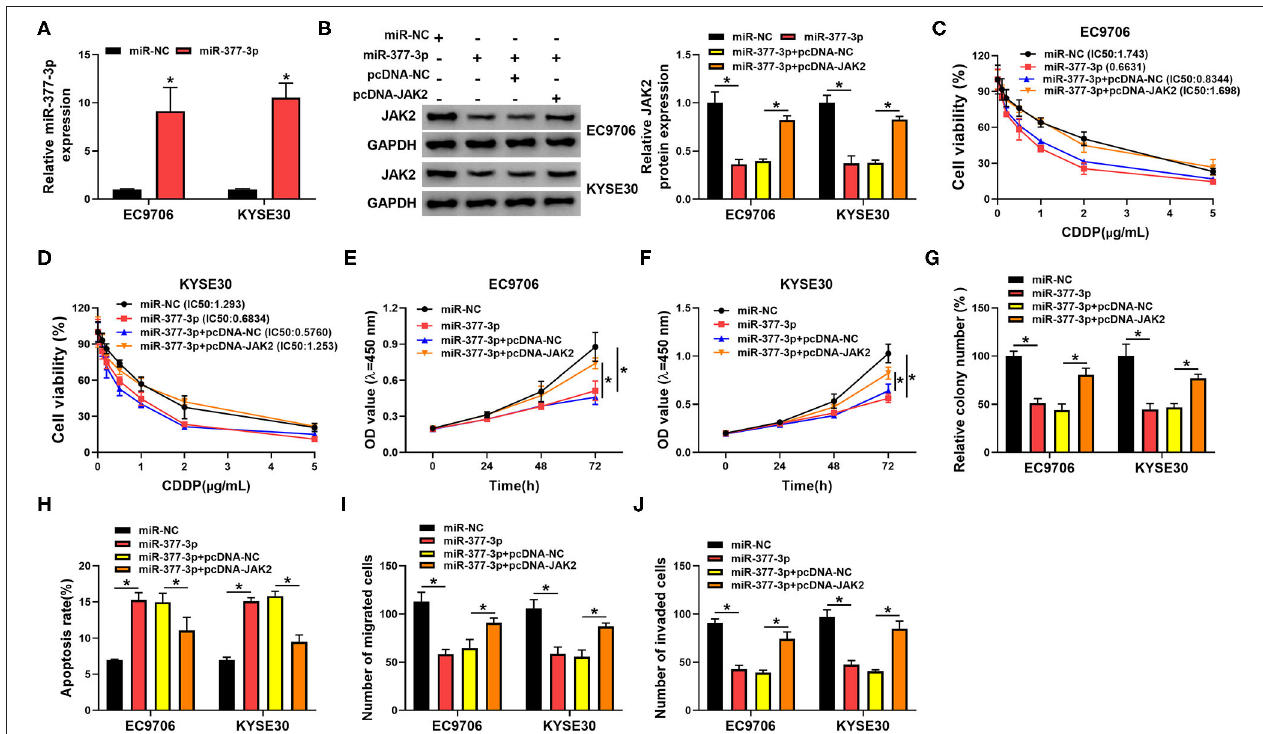
FIGURE 7 | MiR-377-3p weakened the CDDP resistance by regulating JAK2 in esophageal cancer cells. (A) Relative miR-377-3p expression was examined in EC9706 and KYSE30 cells transfected with miR-NC or miR-377-3p. (B–J) EC9706 and KYSE30 cells were transfected with miR-NC, miR-377-3p, miR-377-3p + pcDNA, and miR-377-3p + pcDNA-JAK2. (B) JAK2 protein level was tested in transfected EC9706 and KYSE30 cells. (C,D) CDDP resistance in transfected EC9706 and KYSE30 cells was evaluated using IC50 value of CDDP by CCK-8 assay. (E,F) Proliferation in transfected EC9706 and KYSE30 cells was measured by CCK-8 assay. (G) Colony number in transfected EC9706 and KYSE30 cells was examined by colony formation assay. (H) Apoptosis rate in transfected EC9706 and KYSE30 cells was detected by flow cytometry assays. (I,J) Migration and invasion in transfected EC9706 and KYSE30 cells were analyzed by transwell assays. * P <